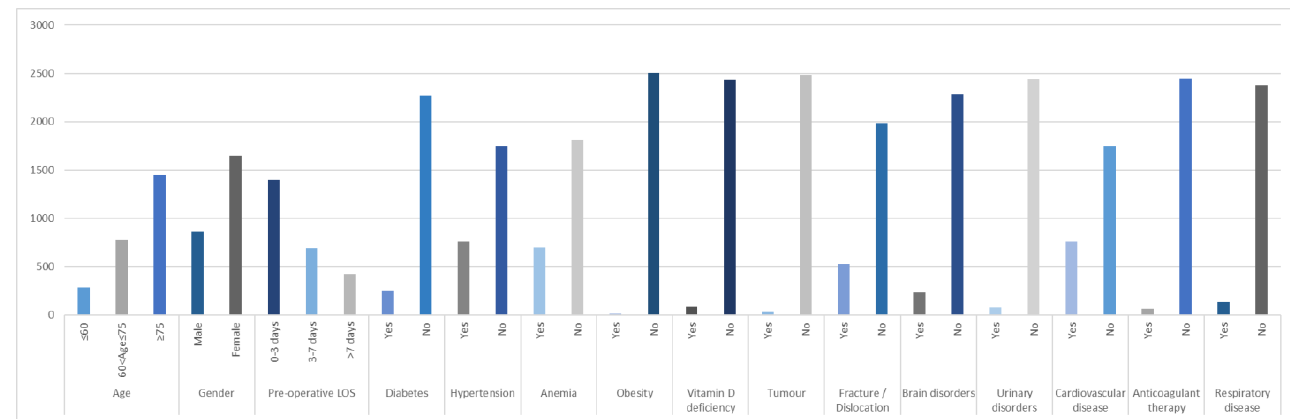
Figure 1. Distribution of the features in the dataset.